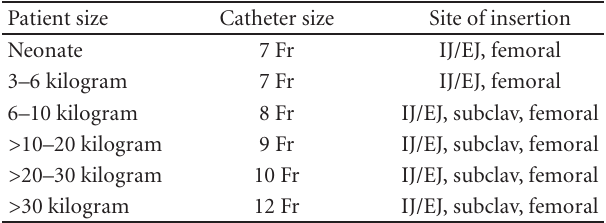
Table 2: Ideal Catheter size and patient size for